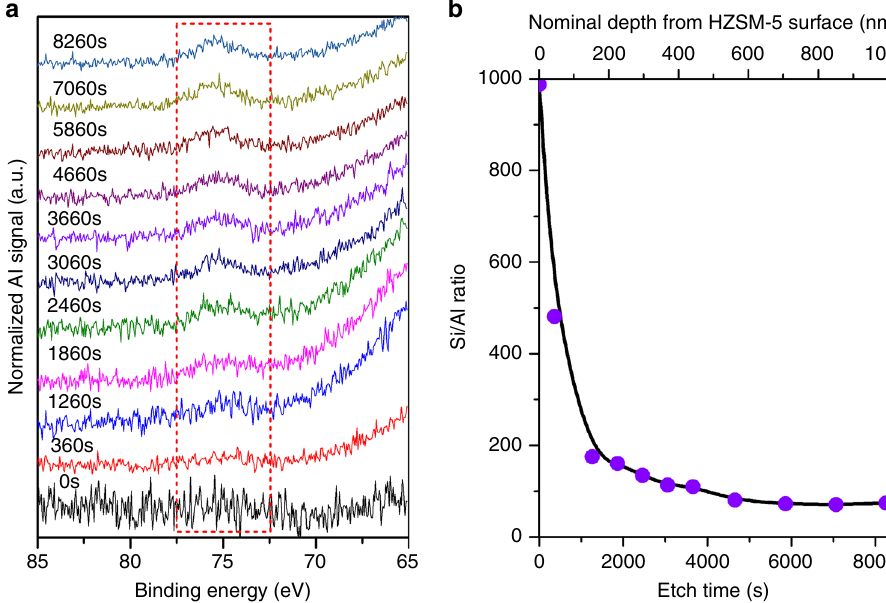
Fig. 2 XPS depth pro fi le of HZSM-5_T. a Evolution of normalized Al 2p XPS peak (marked by dotted red rectangle) intensity with Ar-ion sputtering time and b dependence of the Si/Al ratio on Ar-ion sputtering (etch time, bottom axis) and nominal depth (upper axis) from HZSM-5_T surface (based on Ar- ion sputtering over Ta 2 O 5 fi lm, of which the thickness was reduced by 0.17 nm every second under the same sputtering